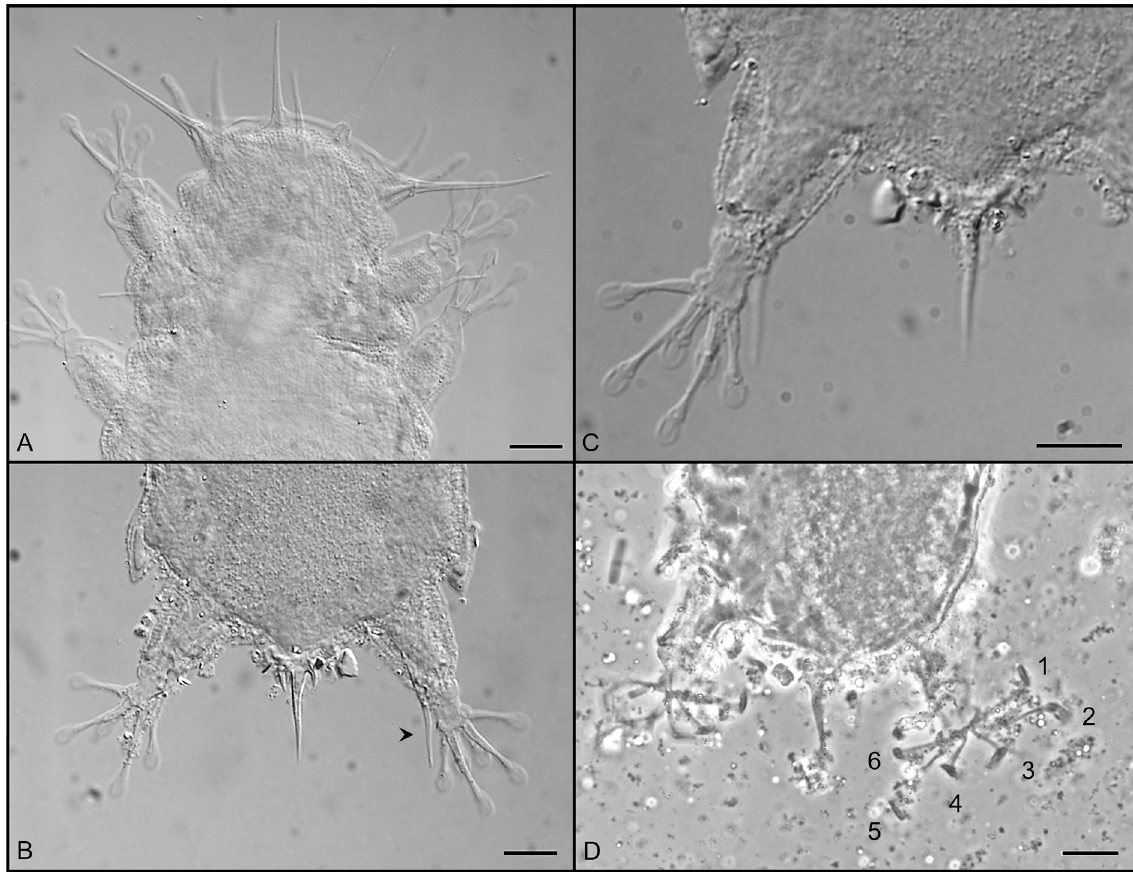
Fig. 8. Batillipes phreaticus Renaud-Debyser, 1959. A–C . Portuguese specimens. A . Anterior region of the body. B . Posterior region of the body, black arrow indicates fourth leg sensory organ. C . Detail of the fourth feet. D . Detail of the fourth feet showing the toe arrangement pattern of a specimen from Scotland in Pollock’s collection. Scale bars = 10